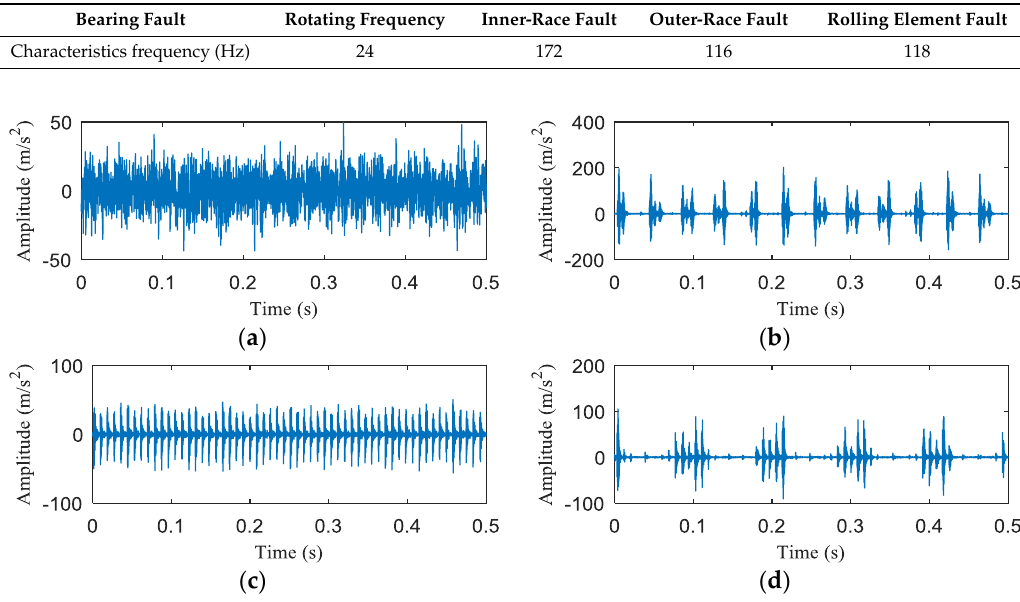
Figure 15. The waveform of ( a ) the normal; ( b ) inner-race fault; ( c ) outer-race fault; ( d ) rolling element fault.